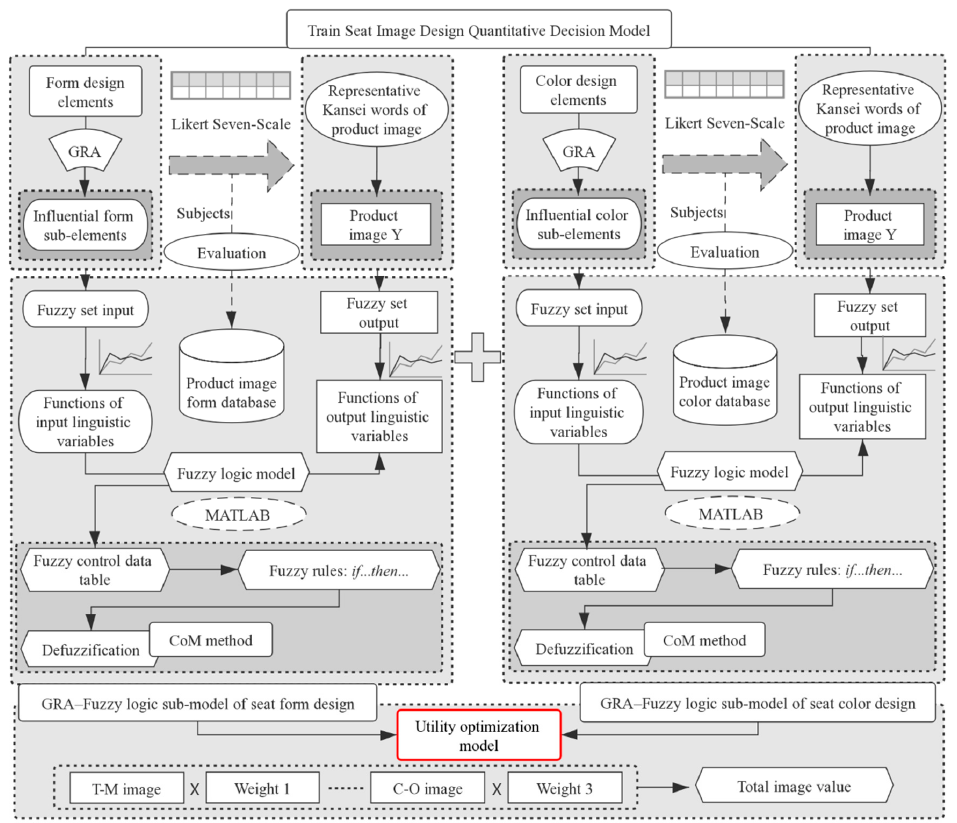
Figure 12. The quantitative decision model of train seat image design.